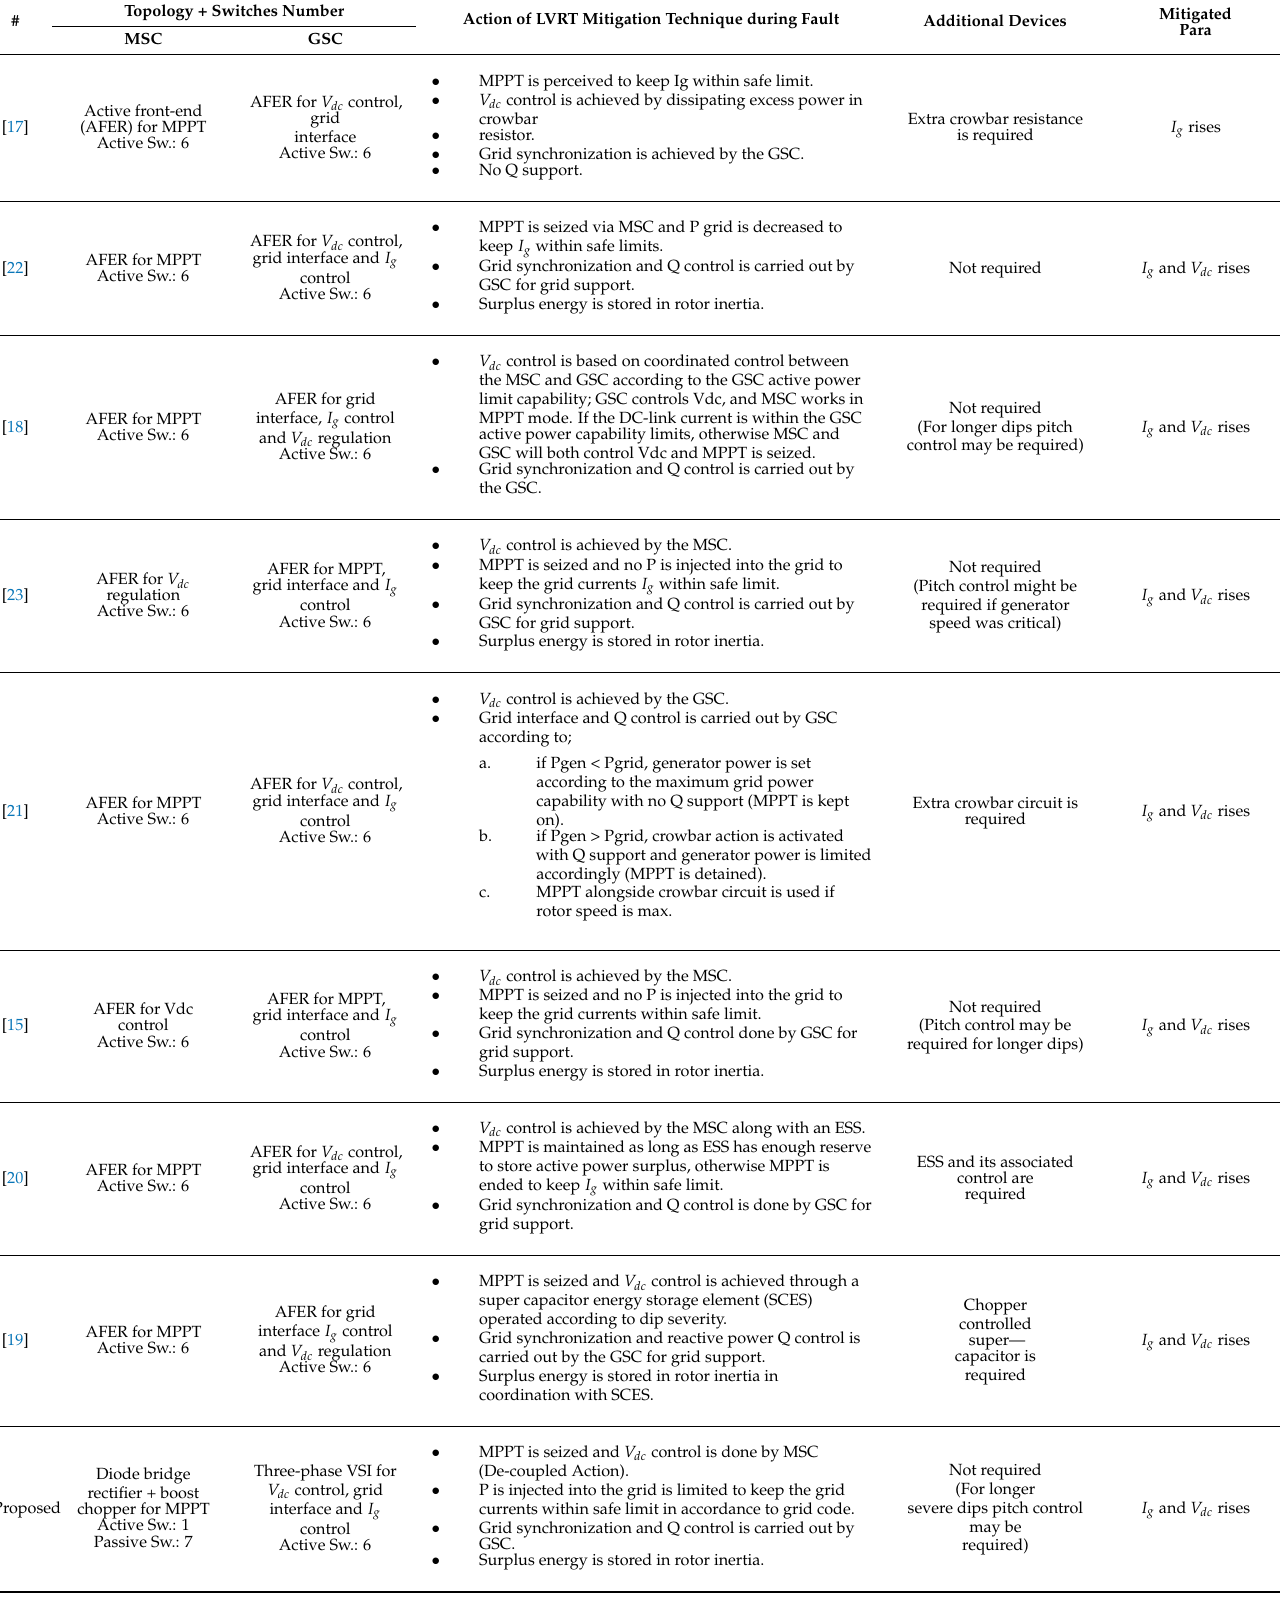
Table 1. Recent LVRT mitigation techniques in grid-tied PMSG